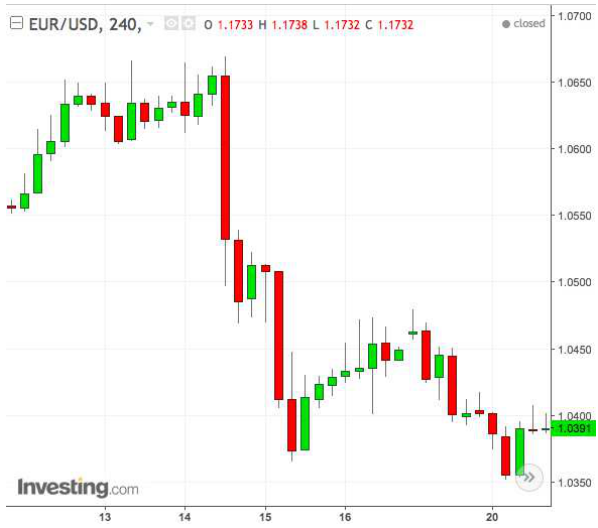
Figure 4. The impact of the increase in the discount rate of the US Federal Reserve (December 14, 2016) on the EUR/USD pair